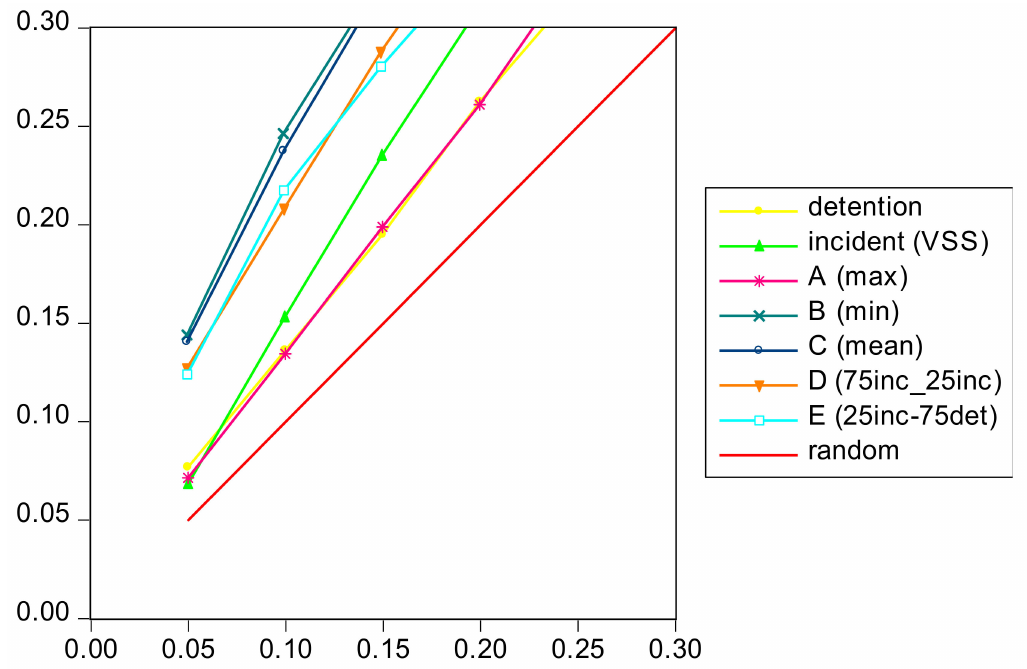
Figure 3. ROC curve top 30%—evaluation variable VSS and detention combined: total count